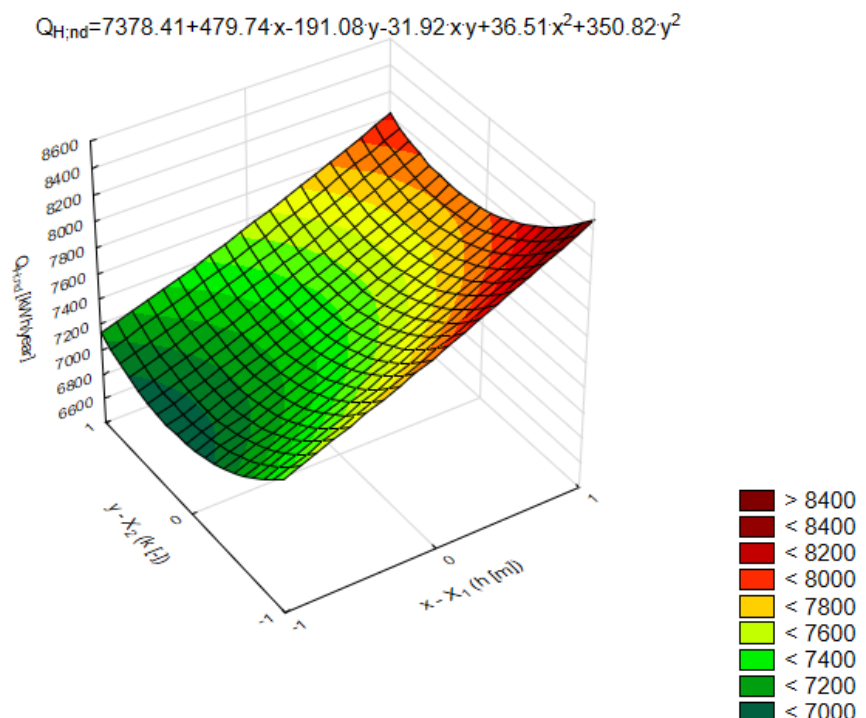
Figure 7. Dependence of Q H;nd on factors from the first group of parameters, i.e., architectural and spatial: X 1 —the height of rooms in the building h and X 2 —the window area changes coefficient k .